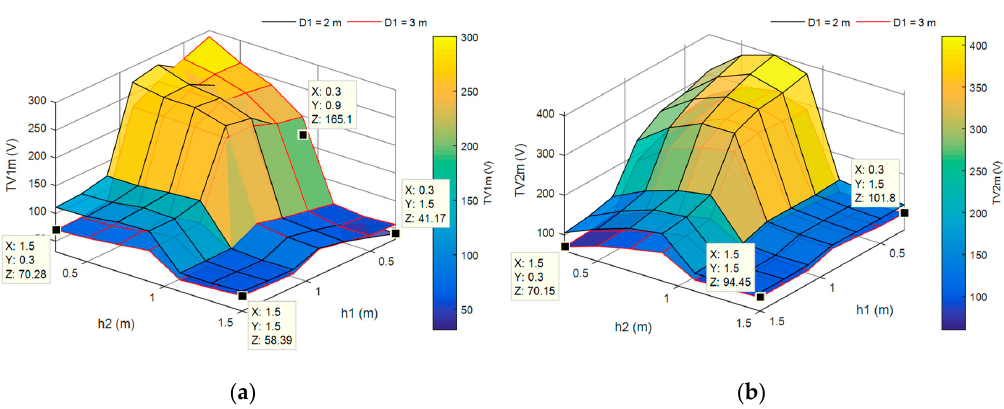
Figure 3. Touch voltage (TV) surfaces, 500 Ω m/100 Ω m/1 m, D 2 = 4 m, ( a ) TV 1m surface; ( b ) TV 2m